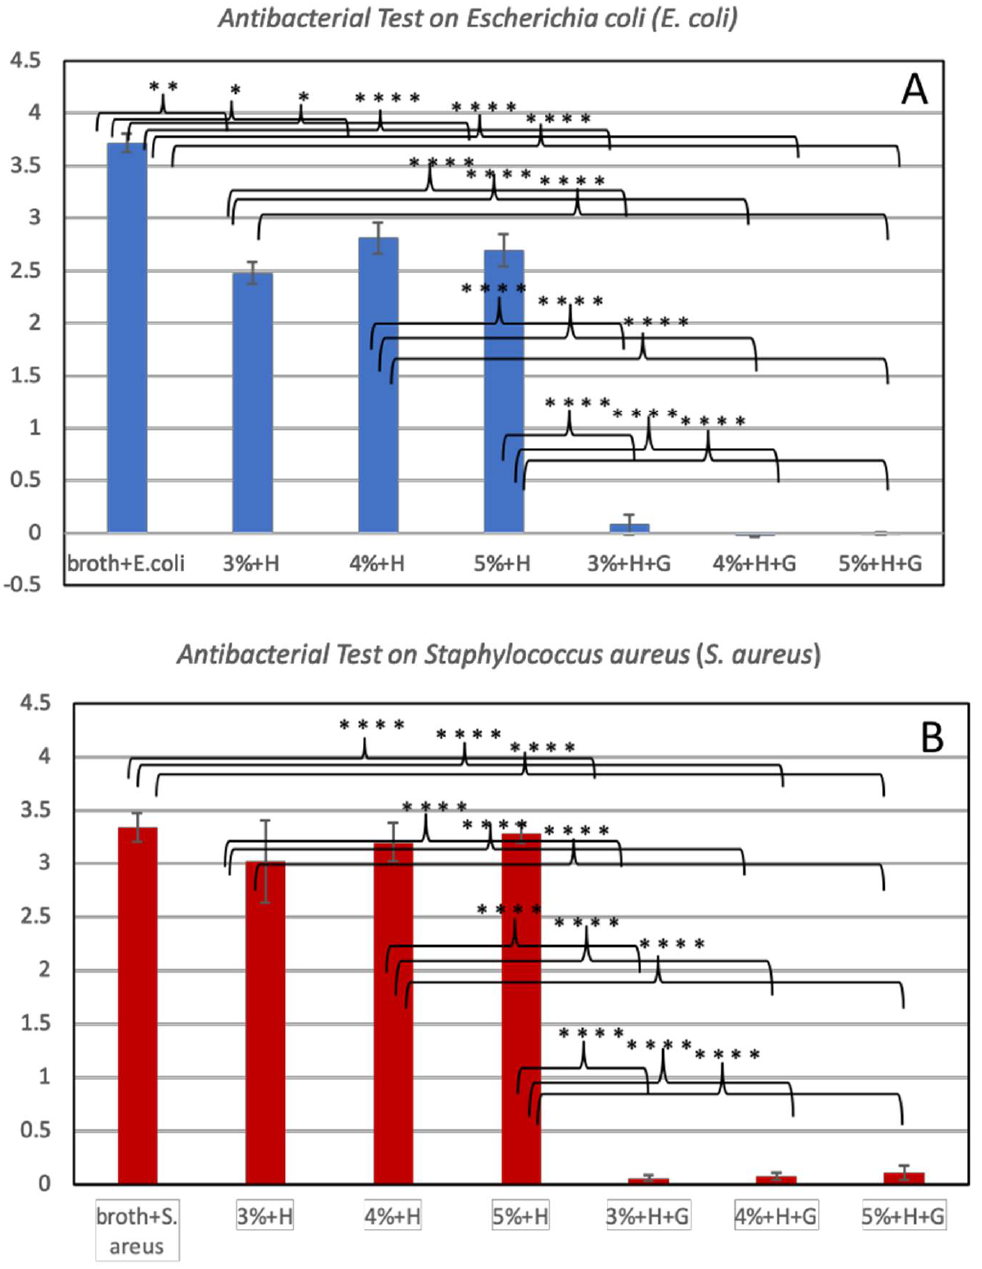
Figure 7. Antibacterial test on E.coli ( A ) and S. aureus ( B ). The absorbance values at 630 nm for: pure bacteria suspension (broth + E. coli, broth + S. aureus ); CS / HNTs without antibodies (3% + H, 4% + H, 5% + H), CS / HNTs with antibodies (3% + H + G, 4% + H + G, 5% + H + G). Error bar with standard deviation. ( ∗ p < 0.05; ∗∗ p < 0.005; ∗∗∗∗ p < 0.00005, n = 3).